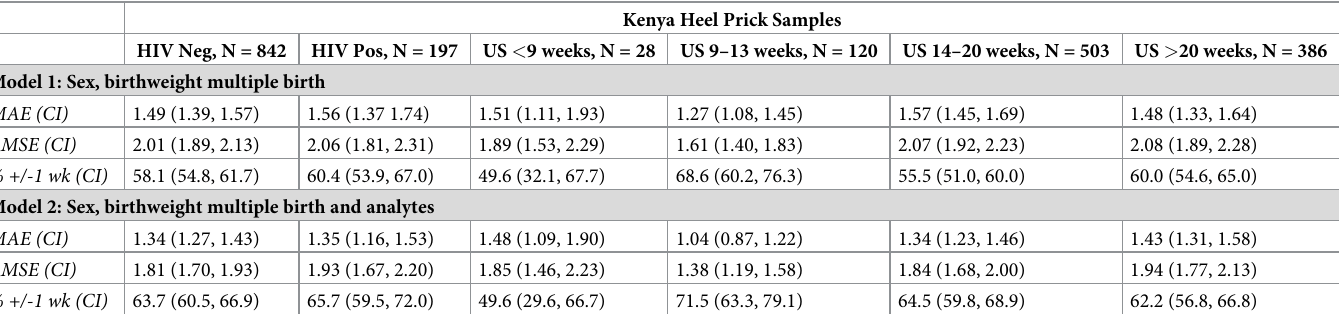
MAE: Mean absolute error; RMSE: Root mean square error; SGA: small for gestational age Data are presented as the mean and 2.5th and 97.5th bootstrap percentiles for MAE, RMSE and the percentage of model estimates within 1 and 2 weeks of ultrasound GA for 1000 bootstrap samples generated from each cohort.